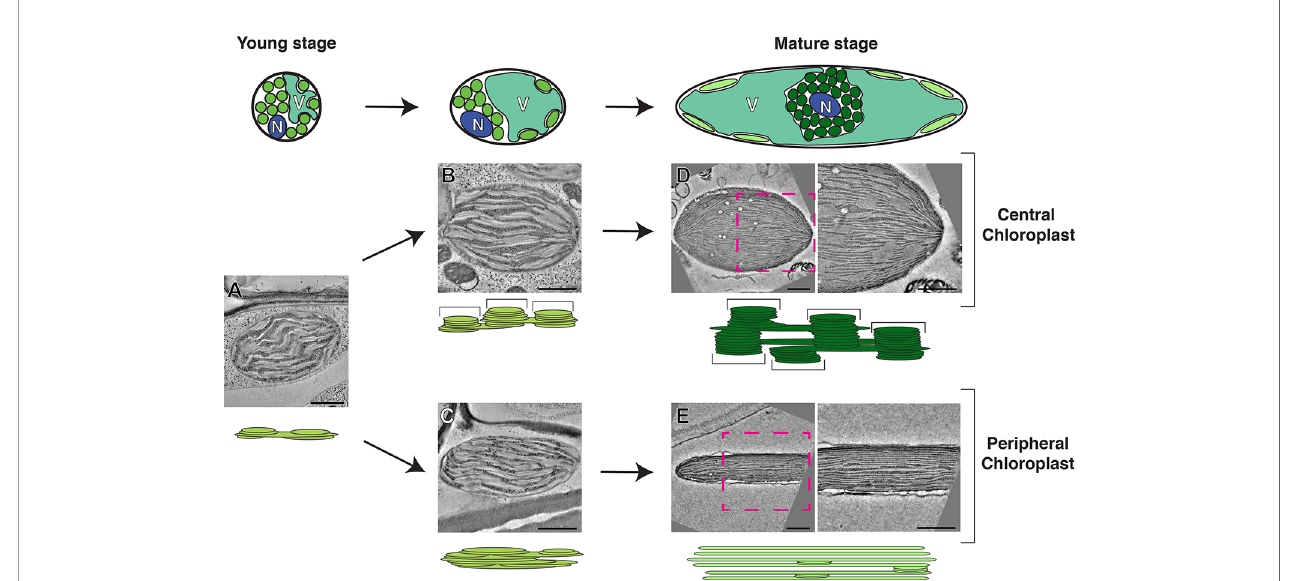
FIGURE 1 | Model of the development of photosynthetic cells and their dimorphic chloroplasts in SCC4 plant Bienertia sinuspersici . Cells at the young stage (left) are small and round. Their cytoplasm has not been divided into central and peripheral regions because their vacuoles have not developed. Chloroplast in the young stage cells have simple thylakoid network with primitive grana stacks (A) . Chloroplasts are being segregated in the intermediate stage cells as the vacuole enlarges (middle). Grana stacks (brackets in the diagram) are discerned from unstacked lamellae in the central chloroplasts (B) while thylakoids in the peripheral chloroplast are more intertwined, making it dif fi cult to distinguish grana stacks from stroma thylakoid (C) . In the mature stage (right), the cells have enlarged and most of the volume of the cell consists of a single vacuole. The central chloroplast (dark green) has taken on an ovoid shape with clearly delineated tall grana stacks (D) . The peripheral chloroplast (light green) has been fl attened into discus shape. The majority of the thylakoid network consists of single-layer stroma lamellae with a smaller number of simple grana stacks (E) . For each stage, thylakoid models and electron tomographic slice images of corresponding chloroplasts are shown. N, nucleus; V, vacuole. Bars indicate 500 nm. The model is based on data published in Akhani et al. (2005); Koteyeva et al. (2016), and Mai et al.